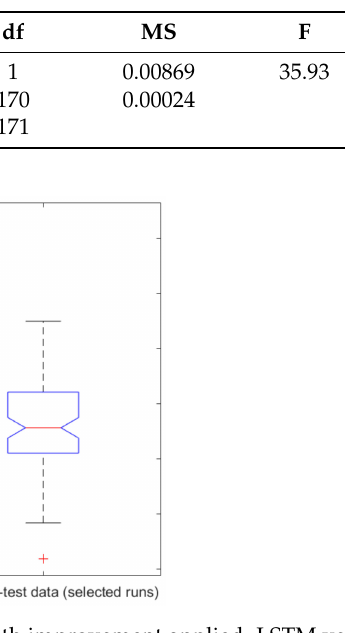
Figure 8. MSE: test data, 86% runs with improvement applied. LSTM versus